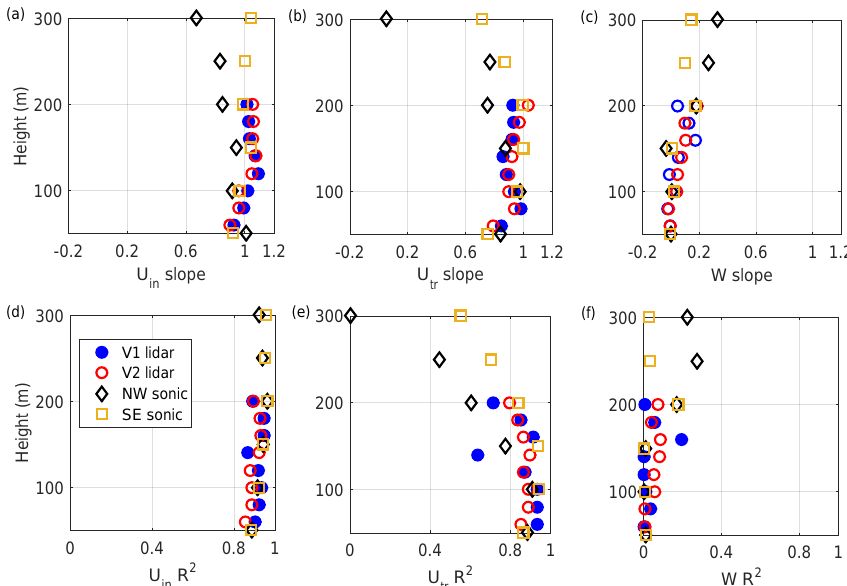
Figure 7. Linear regression of the 3-D velocity retrieved from the triple RHI scans for virtual tower 1 and compared with the lidar profilers V1 and V2, and the NW and SE sonic anemometers: (a) slope of the in-plane horizontal velocity, U in ; (b) slope of the transversal horizontal velocity, U tr ; (c) slope of the vertical velocity, W ; (d) R 2 value of the in-plane horizontal velocity, U in ; (e) R 2 value of the transversal horizontal velocity, U tr ; (f) R 2 value of the vertical velocity, W